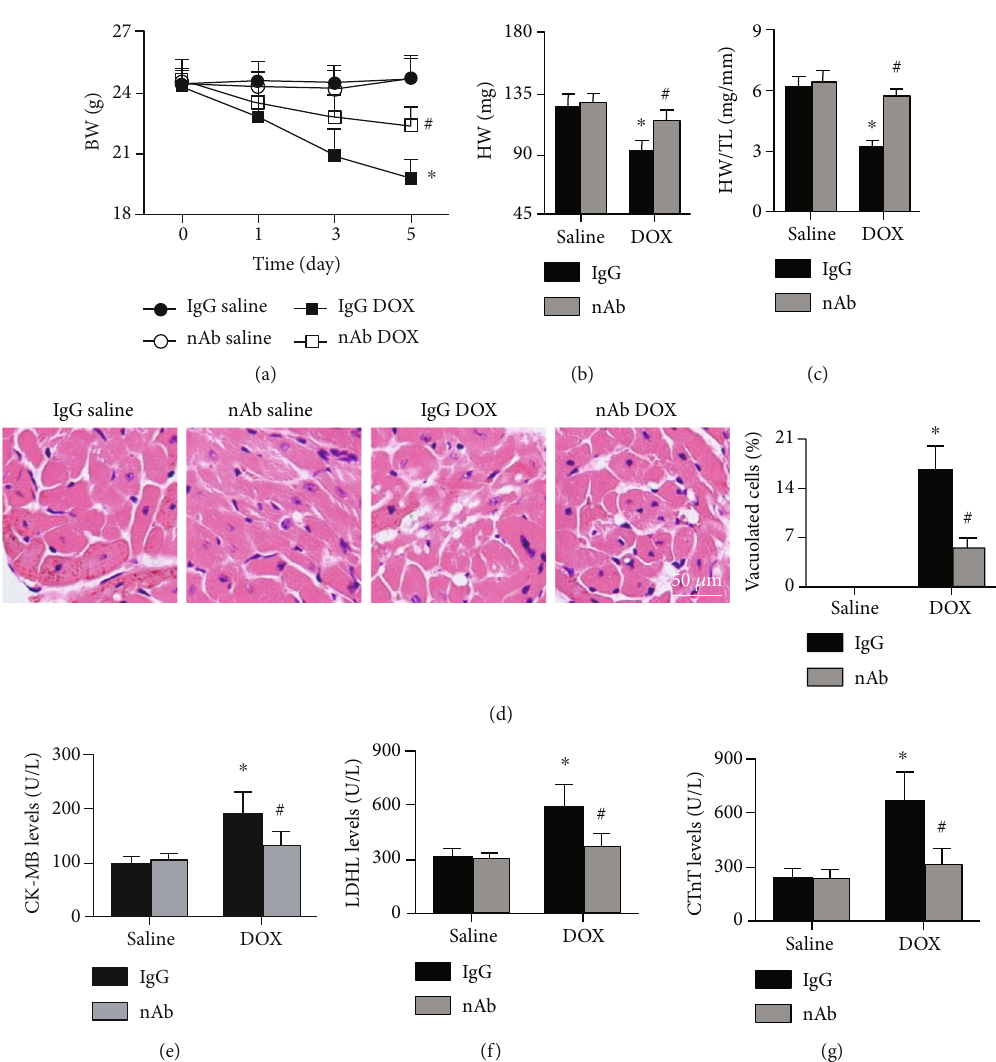
Figure 2: E ff ects of anti-IL-16 nAb on DOX-induced cardiac injury. (a) BW changes at di ff erent time points in the four groups (ANOVA). (b, c) HW and HW/TL ratios in each group (ANOVA). (d) HE staining and cardiomyocyte vacuolization analysis of each group (200x, nonparametric test). (e-g) Serum LDH, CK-MB, and cTnT levels were detected (ANOVA). N = 5 -10 for each group. ∗ p < 0 : 05 vs. the IgG saline group. # p < 0 : 05 vs. the IgG DOX Table 2: Data of evaluation of LV function by echocardiography and hemodynamic data of the four groups. Group IgG saline nAb saline IgG DOX nAb DOX Statistical method -dp/dt (mmHg/s) 4811 ± 695 # ANOVA N = 10 for each group. ∗ p < 0 : 05 vs. the IgG saline group. # p < 0 : 05 vs. the IgG saline group.